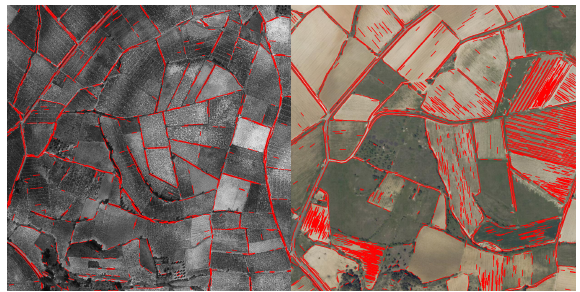
Figure 2. Illustration of over-detection problem when using an orthoimage as reference Left : old photograph; right : current orthoimage. Lines are detected with LSD algorithm. Hence our method requires the existence of such a TopoDB